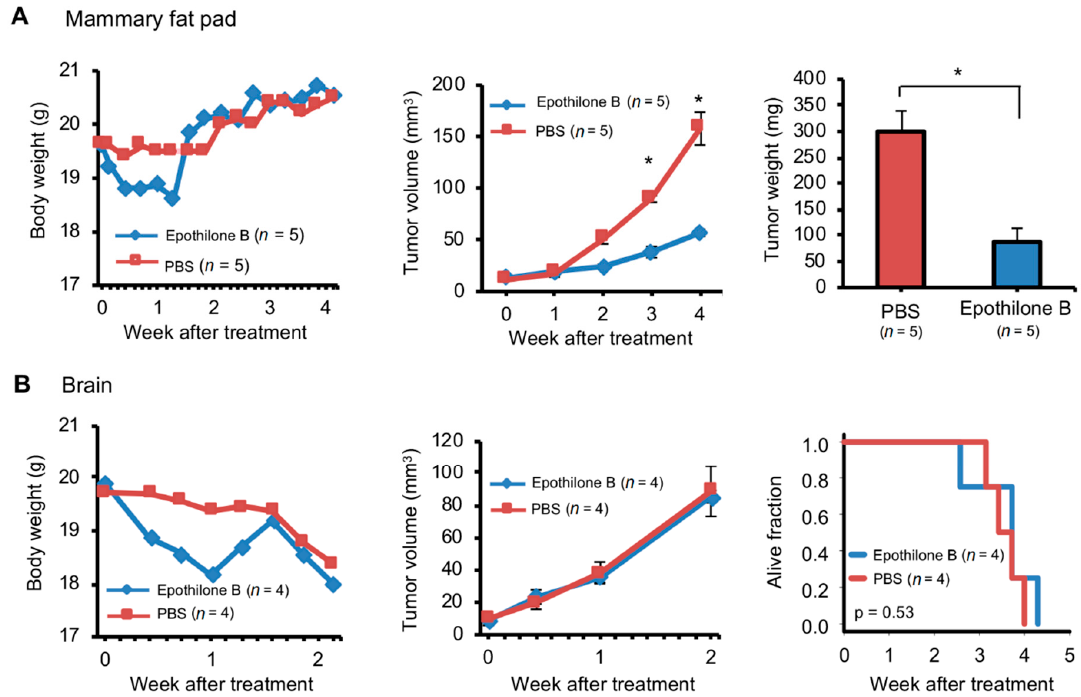
Figure 6. Different responses to chemotherapy of breast cancer patient brain metastasis implanted in the mouse brain or mammary fat pad. Brain metastasis of one triple negative breast cancer patient was used for this experiment. Tumor was prepared with the mincing method for implantation (1 µL tumor + 2 µL phosphate-buffered saline [PBS]) in the mouse mammary fat pad ( A ) or brain ( B ) with the Pipette or Forceps method respectively. Implanted tumors were then passaged three times at the same implantation site. Mice with tumors after third passage were intravenously injected with one dose of epothilone (4 mg/kg) or PBS when tumors were ~10 mm 3 in volume. Growth of tumors was measured with calipers ( A ) or magnetic resonance imaging ( B ). Body and tumor weights and tumor volumes are plotted (mean and standard error). p values in standard t tests for group comparison are indicated (* ≤ 0.05). Survival plot for mice with tumors implanted in brain is also shown ( p value determined with logrank test).